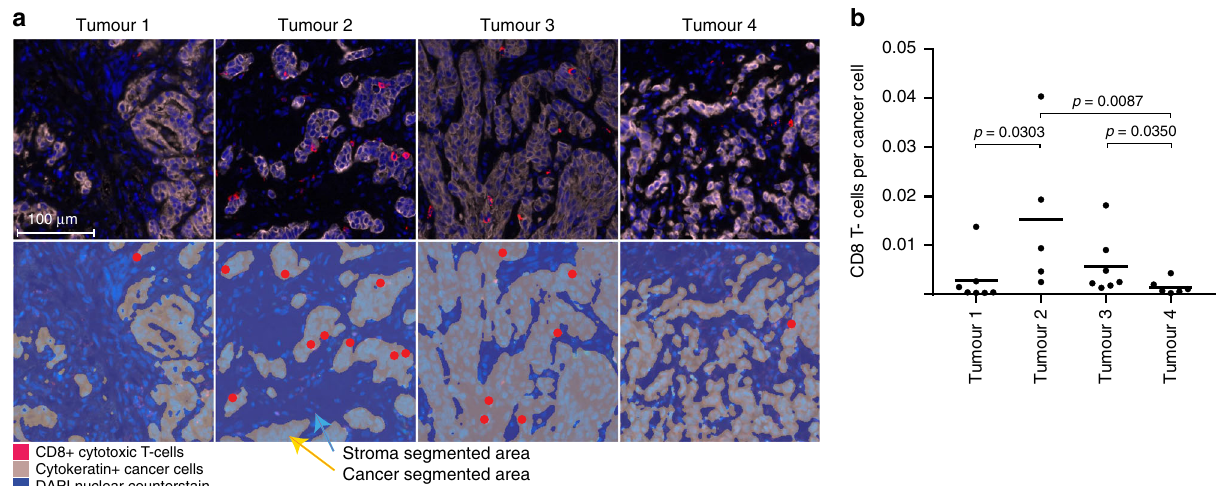
Fig. 4 CD8 + T-cell in fi ltrates in dMMR GOAs. a Representative images of CD8 + T-cell in fi ltrates in Tumours 1 – 4. Upper row: fl uorescent composite IHC image showing cancer cells and CD8 + cytotoxic T-cells. Bottom row: segmentation of cancer areas (grey, yellow arrow) and stroma (blue, light blue arrow) allowed to only count the highlighted CD8 + T-cell in cancer areas. b The ratio of CD8 + T-cells divided by the number of cancer cells (cytokeratin- positive cells) for all regions of Tumours 1 – 4. Black bar: median; p -values (Spearman rank test) are shown for signi fi cant differences.